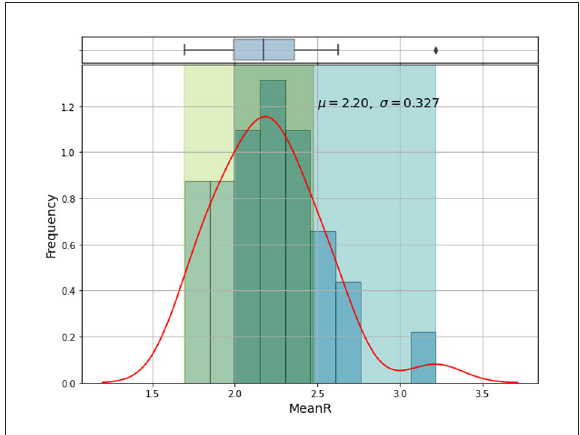
FIGURE3 Frequency distribution and histogram of MeanR of all waves.